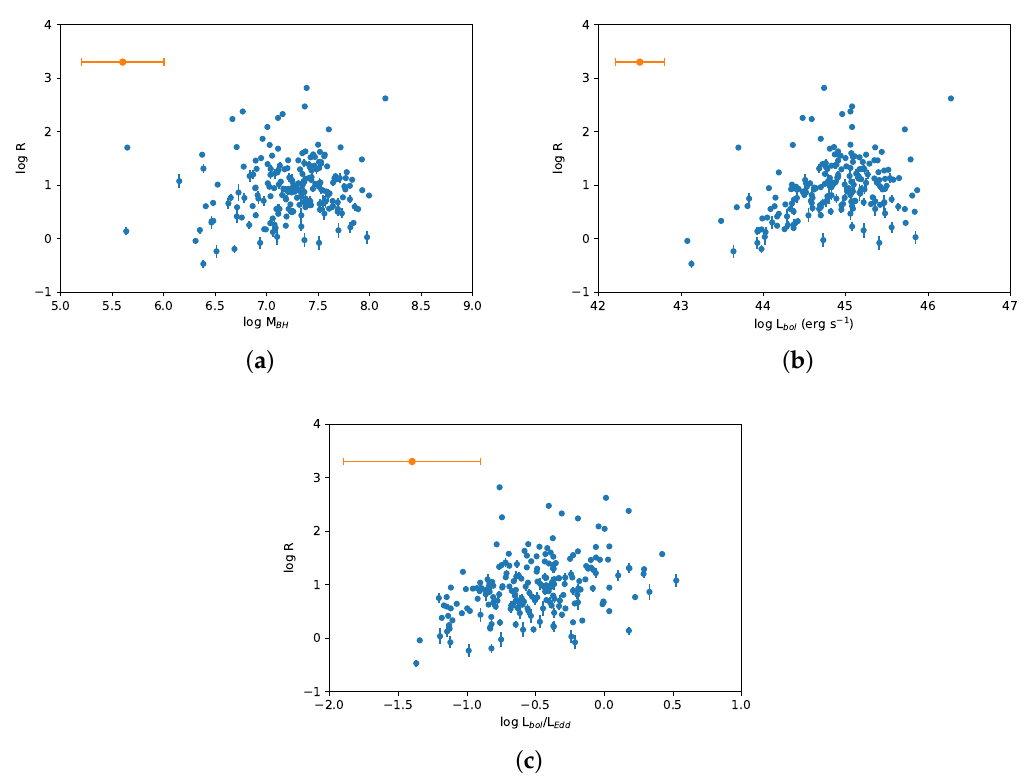
Figure 5. The dependence of radio loudness on the black hole mass ( a ), disk luminosity ( b ), and Eddington ratio ( c ). On the top left corner of each panel, the typical uncertainties of black hole mass, disk luminosity and Eddington ratio are labeled,